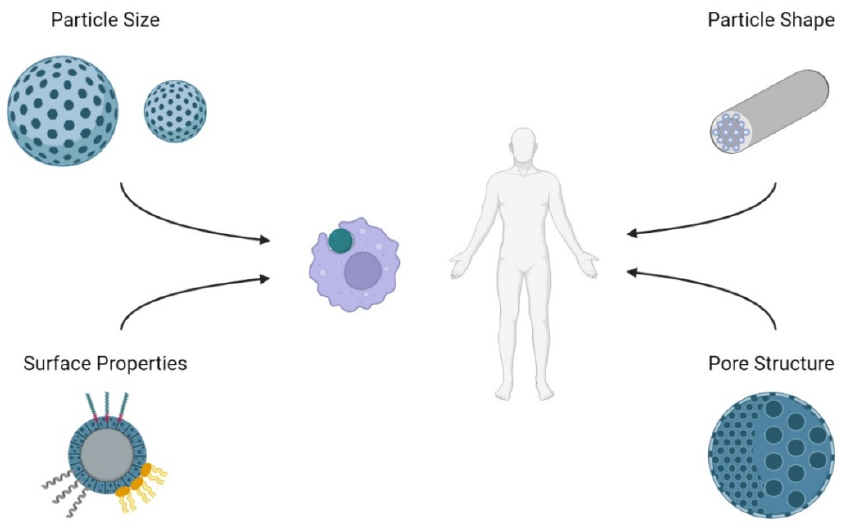
Figure 3. Properties of mesoporous silica and their effect in vivo. Effect of particle size, particle shape, surface functionalization, and pore structure should be considered in regard to cellular uptake, biodistribution, and toxicity.